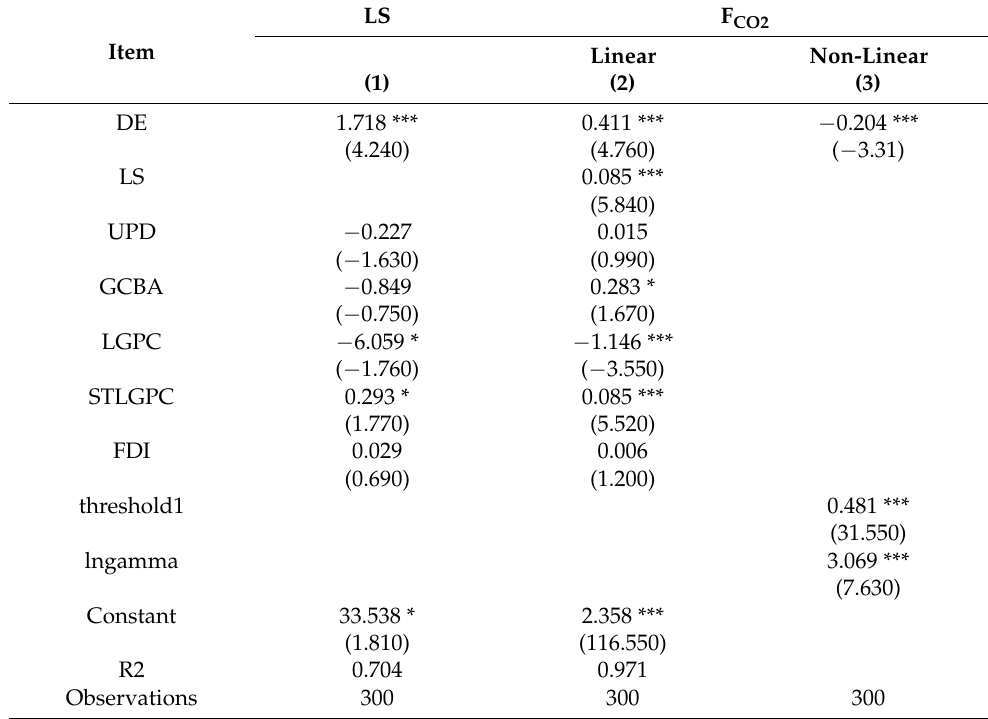
Table 8. Mediating effect test